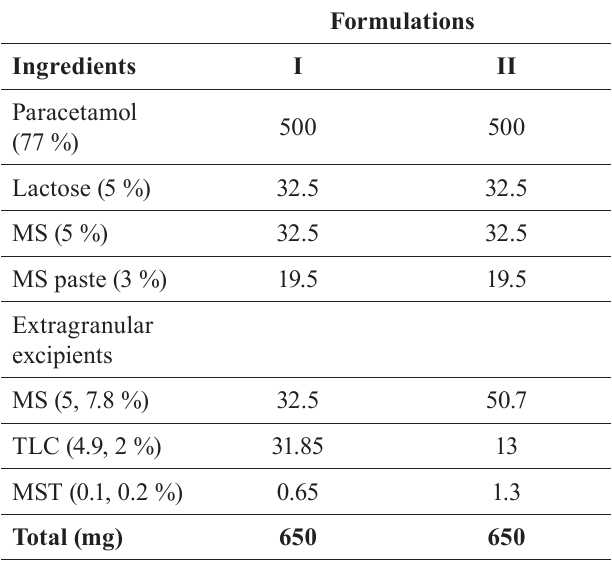
TABLE III - Formula for preparing paracetamol